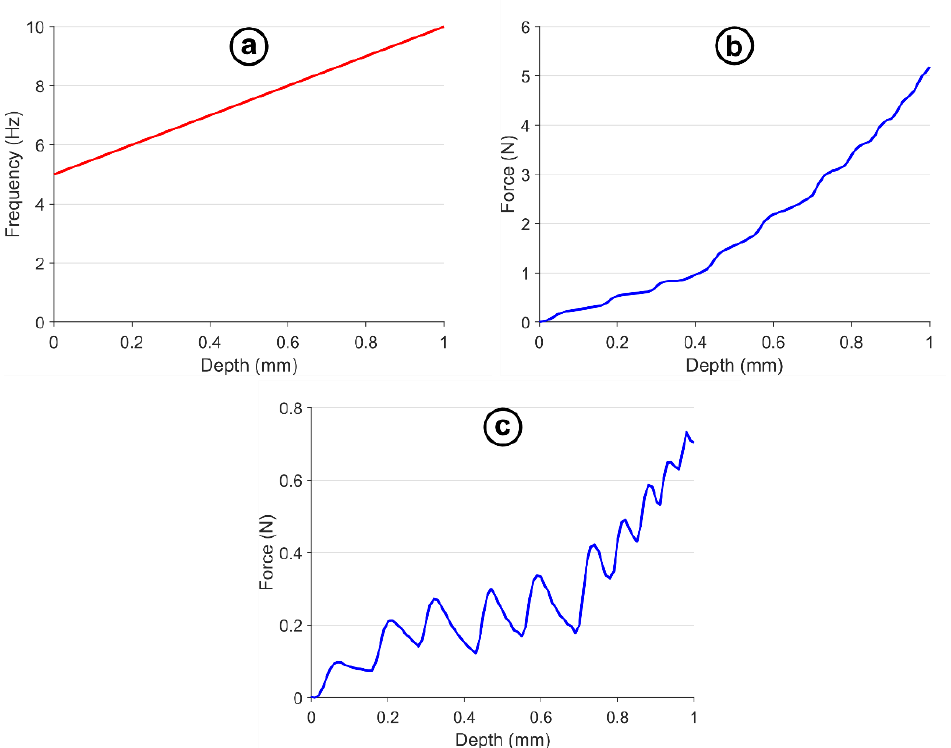
Figure 12. Results of the mapped frequency experiment: ( a ) programmed frequency with respect to indentation depth; ( b ) force – depth curve a 4 kV square wave with depth-dependent frequency; ( c ) isolated force due to the ER effect.